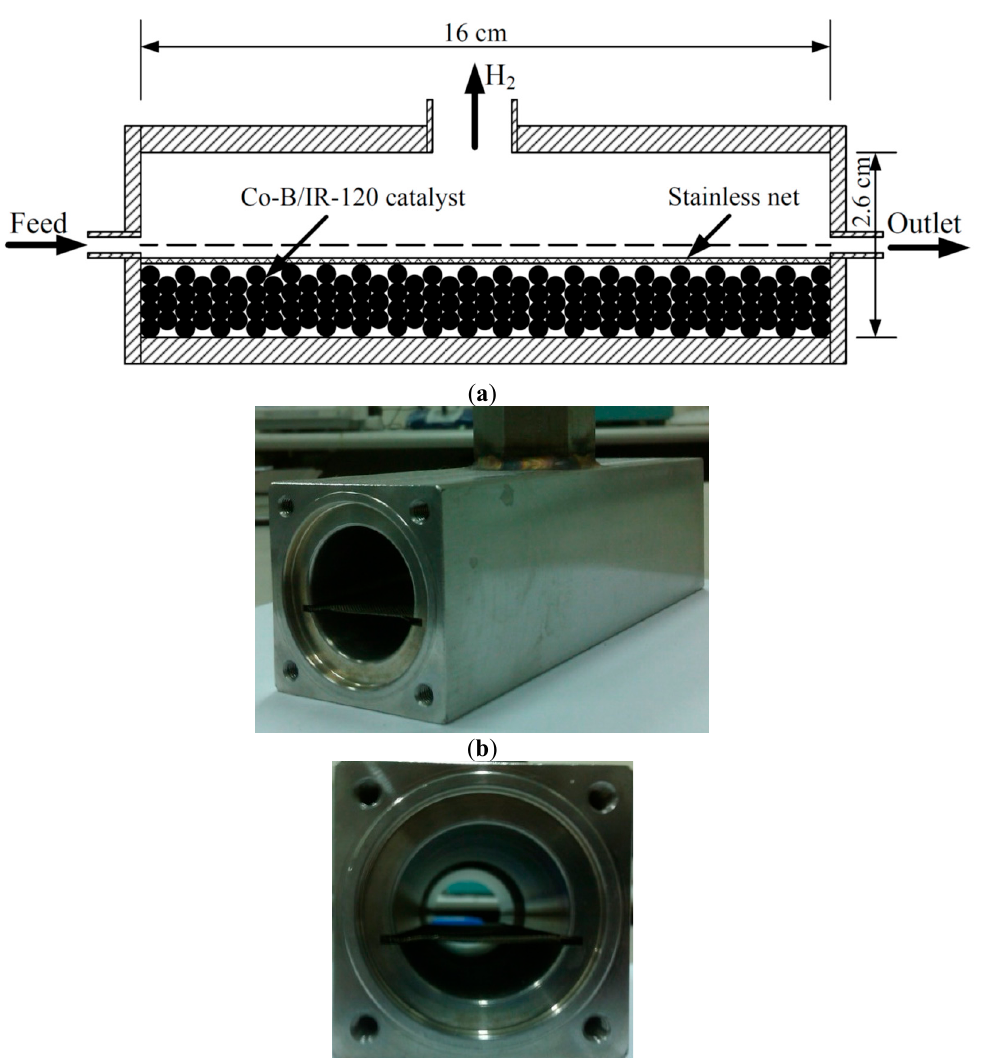
Figure 2. Reactor configuration for hydrogen generation using sodium borohydride hydrolysis reaction ( a ) mechanical diagram, photographs of experimental setup ( b ) 45 degree view, ( c ) side view.